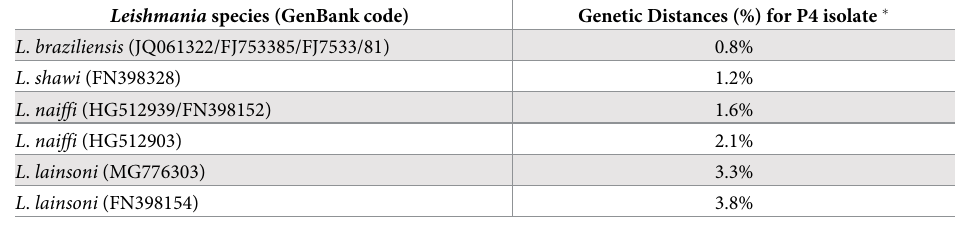
Table 4. Genetic distance percentage between P4 isolate and other Leishmania species in ITS1-rDNA sequences obtained from